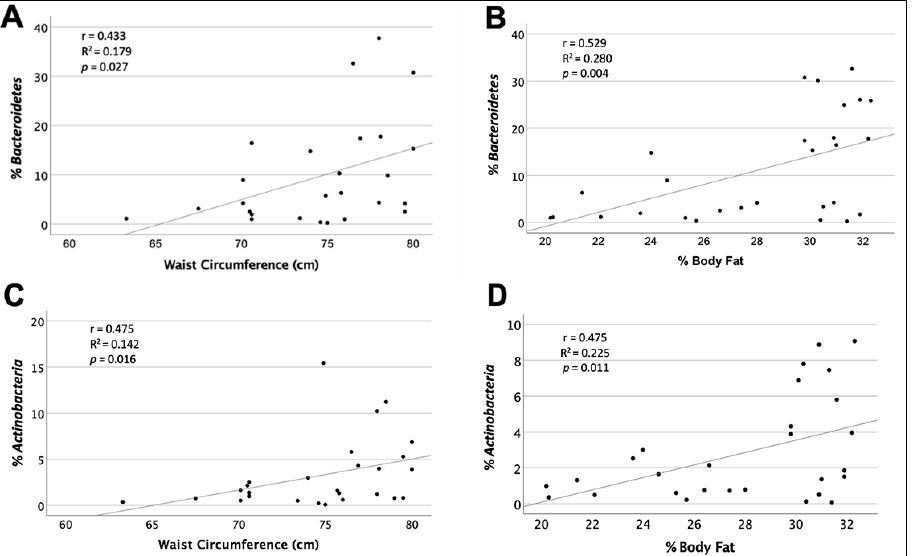
Figure 1. Correlation of the percentage of Bacteroidetes and Actinobacteria with waist circumference ≤80 cm and percentage of body fat ≤33% . A. Regression between maternal waist circumference ≤80 cm and the percentage of the Bacteroidetes phylum in human milk; B. Regression between the percentage of maternal body fat ≤33% and the percentage of the Bacteroidetes phylum in human milk; C. Regression between maternal waist circumference ≤80 cm and the percentage of the Actinobacteria phylum in human milk; D. Regression between the percentage of maternal body fat ≤33% and the percentage of the phylum Actinobacteria in human milk.